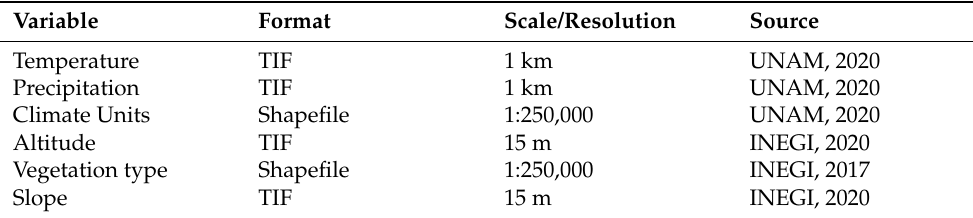
Table 9. Variables used in the multi-criteria analysis to determine the potential distribution of Euphorbia fulgens